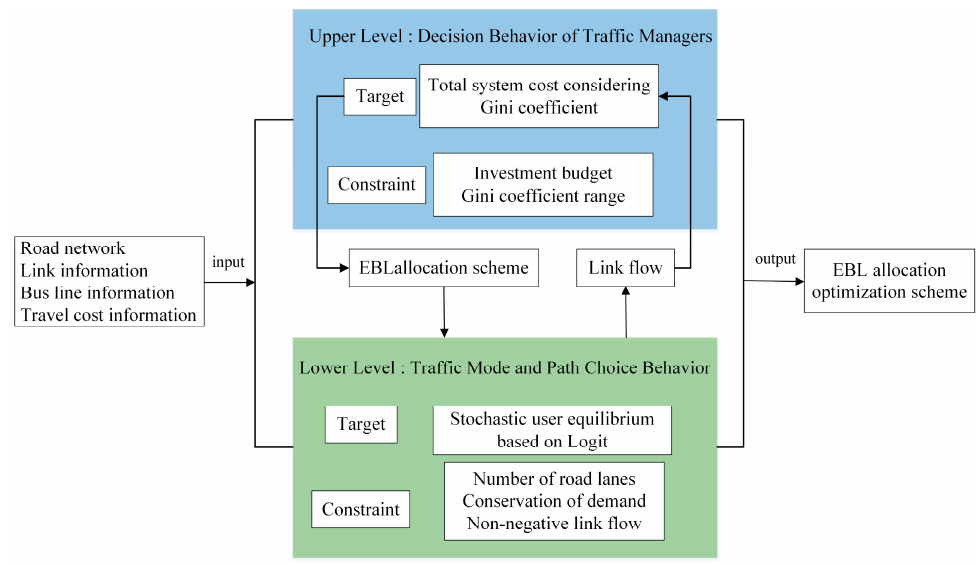
Figure 2. Bi-level programming model.